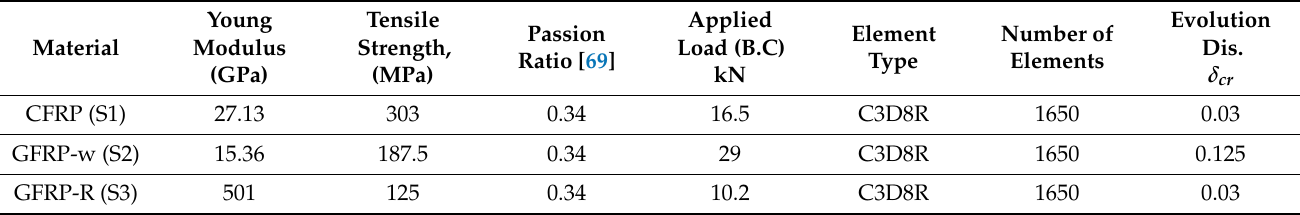
Table 2. All XFE model parameters and